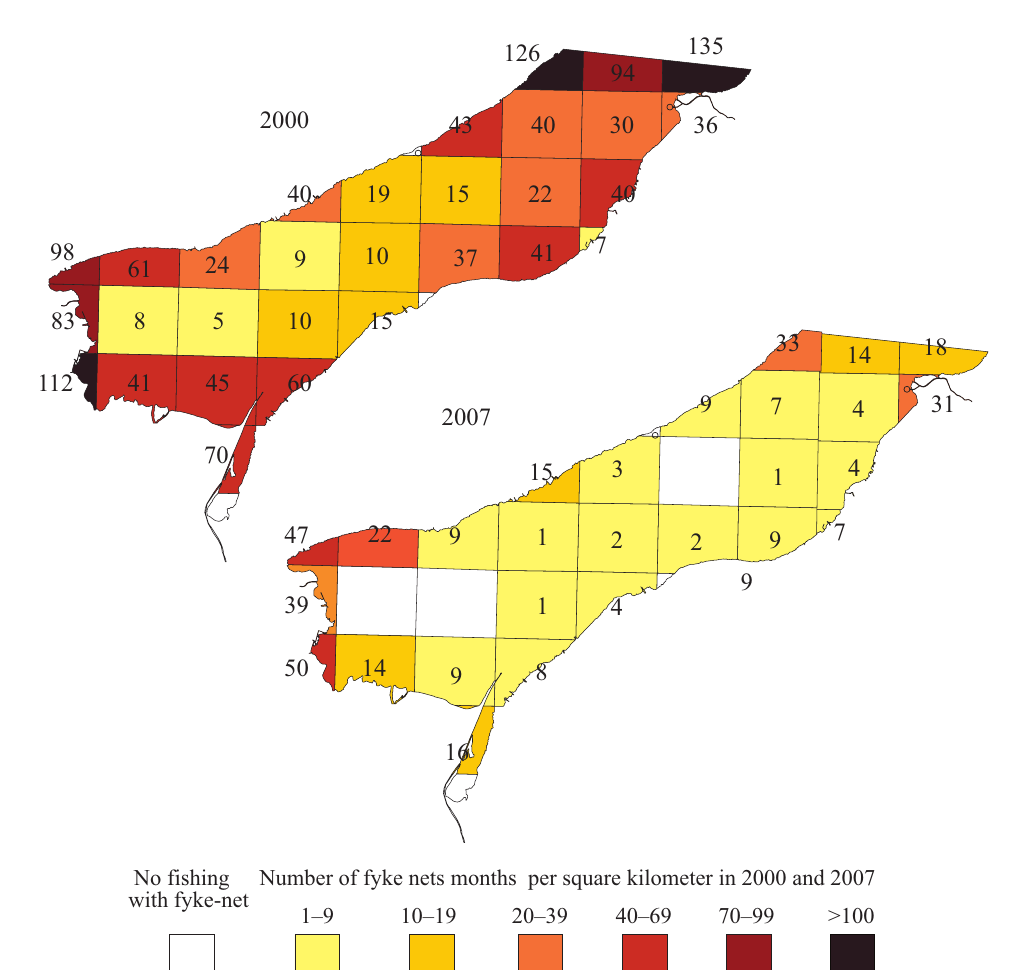
Fig. 3. Distribution of fyke nets in the lagoon in the 2000–2007 period